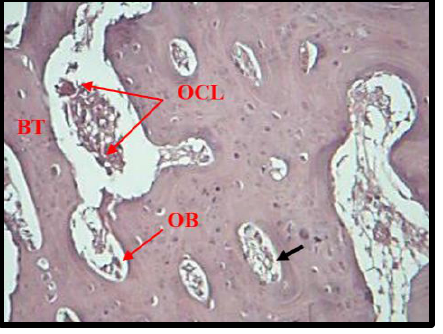
Figure 5: Microscopic view of uncoated implant after 6 weeks. Dense bone trabeculae (BT). Osteoblasts (OB). Osteoclasts (OCL). Haversian canal (black arrow). H & E × 20.